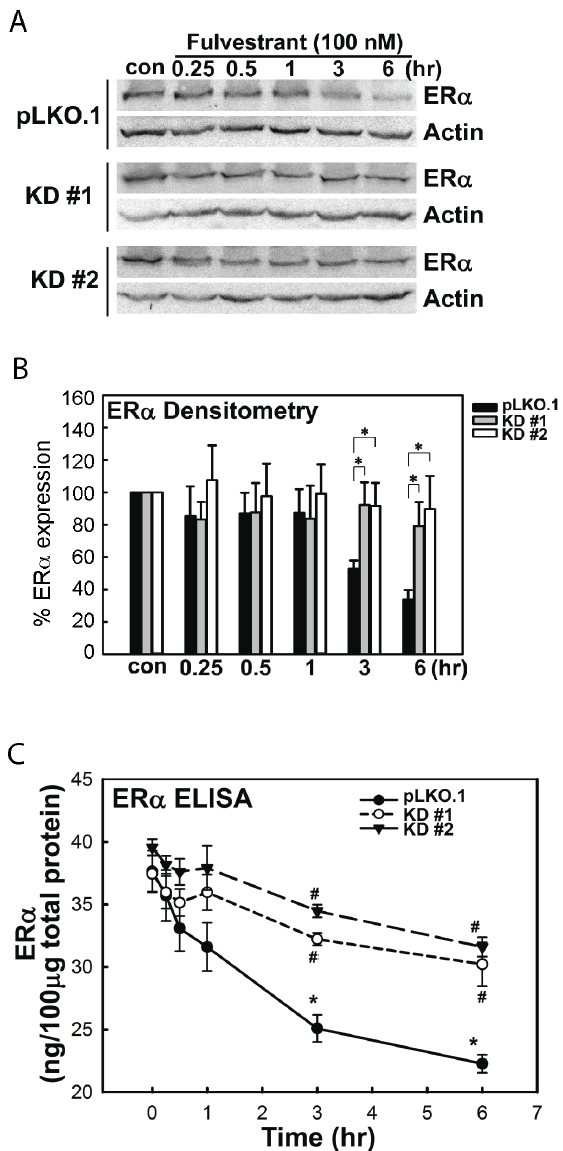
Figure 4. CSK is required for fulvestrant-induced ER a protein degradation in MCF-7 cells. (A, B) RNAi knockdown of CSK protein expression caused resistance of intracellular ER a protein to fulvestrant- induced degradation: Western blotting. Cells were infected with control (pLKO.1) or two CSK-knockdown shRNA lentivirus clones and subjected to exposure to fulvestrant. Expression of ER a protein was determined by Western blotting at varying time points of exposure (A). Intensities of ER a protein bands were determined by densitometry (B, mean 6 SEM of three independent experiments. Asterisk indicates statistical signifi- cance, p , 0.05). (C) Similar experiments as shown in panels (A, B) were performed, but amounts of ER a protein in total cellular protein were determined by ELISA (mean 6 SEM of three independent experiments; *, p , 0.05 to vehicle control; # , p , 0.05 to pLKO.1-infected cells exposed to fulvestrant for the same